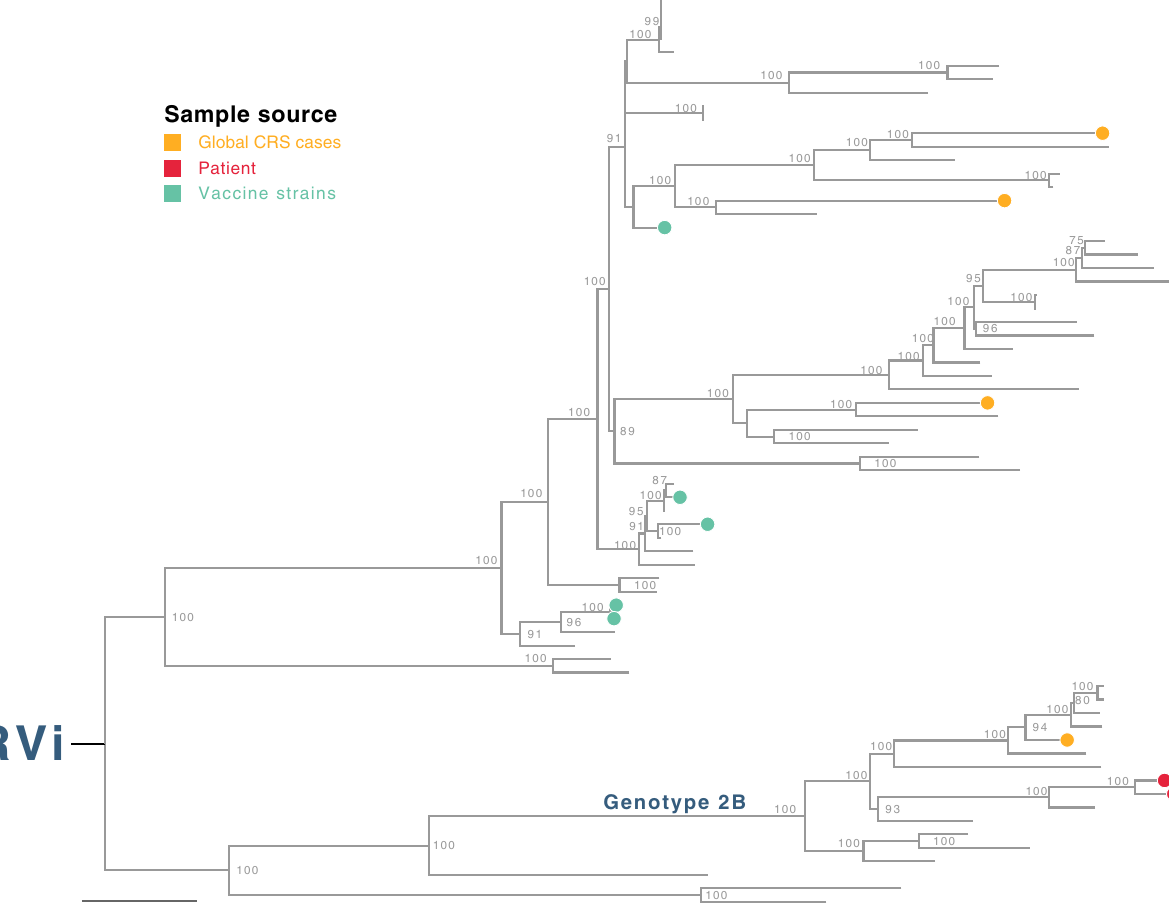
Figure 4. Human rubella virus (RVi). Maximum-likelihood phylogenetic tree was inferred comparing two RVi genomes (all from KCH pneumonia patients cohort, indicated as red circles) to global genomes. The global RVi strains identified in confirmed CRS cases were indicated as orange circles in the tree, and RVi vaccine strains were indicated as green circles. The tree was mid-point rooted for clarity and horizontal branch lengths were drawn to the scale of nucleotide substitutions per site, and significant bootstrap values were shown for major